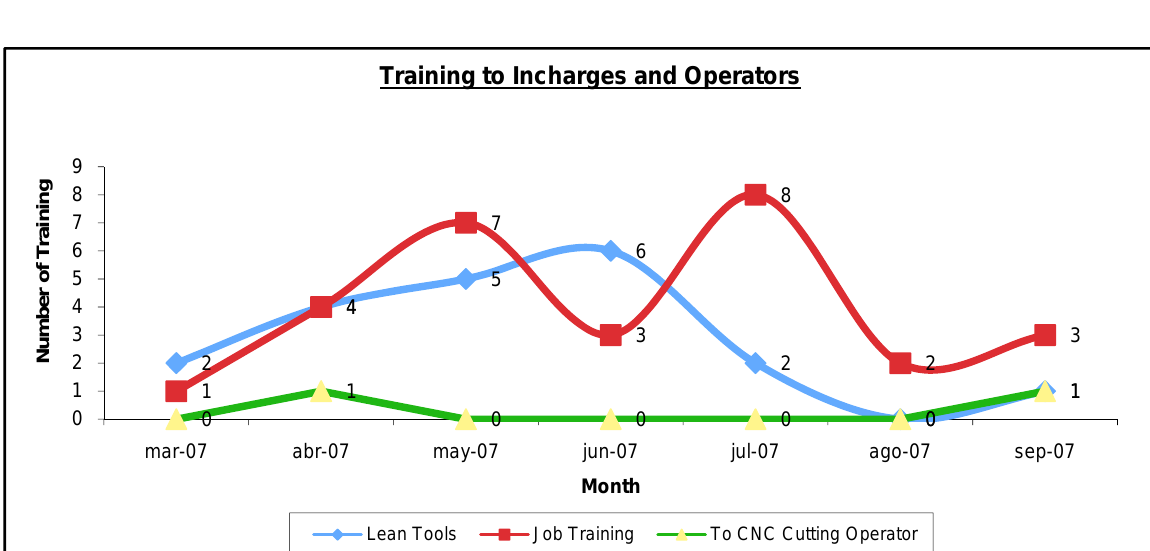
Table 7. “Root cause detection on the cutting torch”.